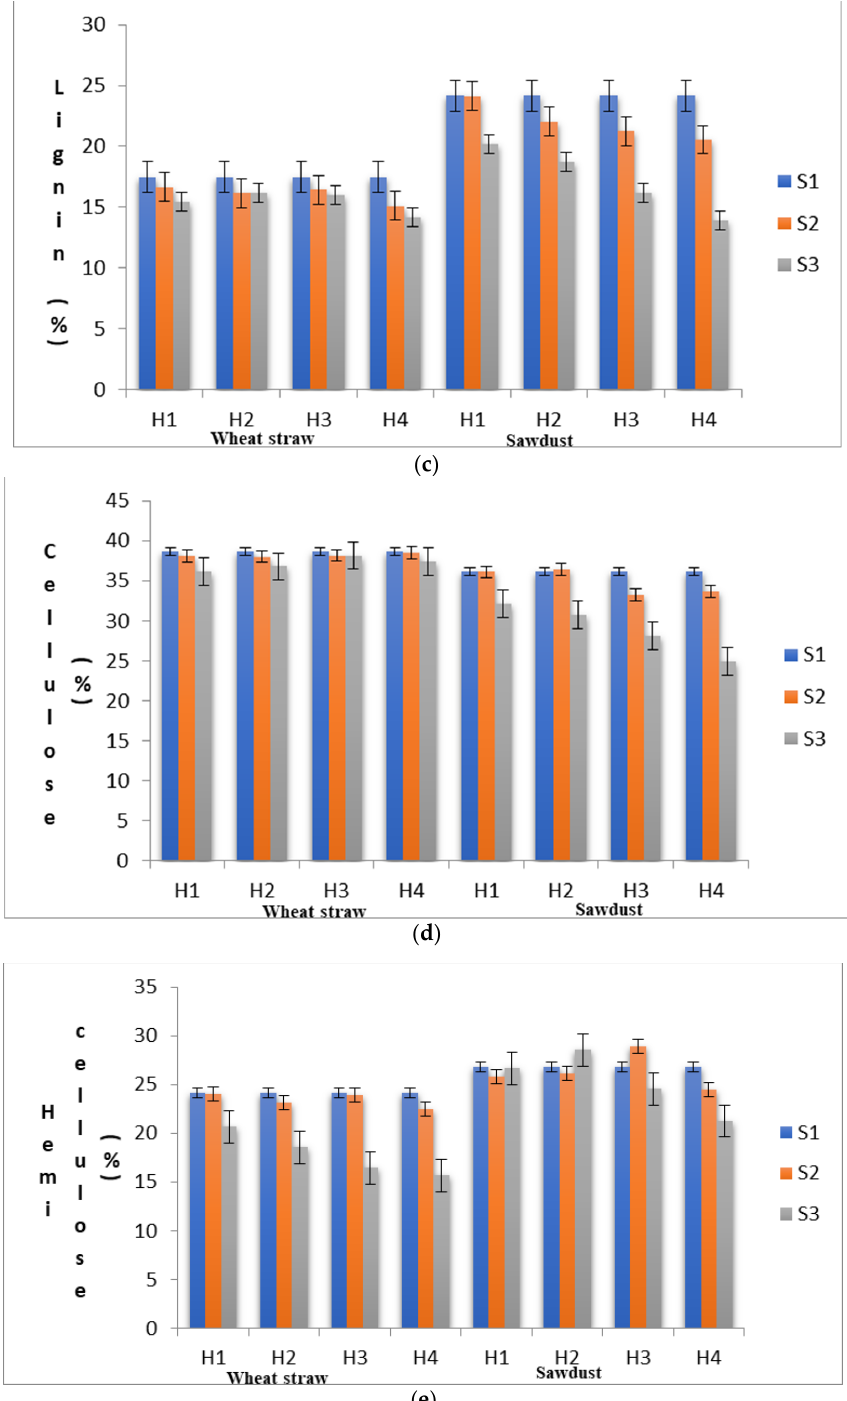
Figure 1. ( a ) Substrates’ moisture content in various experimental stages as influenced by pre heat treatment and subsequent SSF. ( b ) pH levels of the substrates in various experimental stages as influenced by pre heat treatment and subsequent SSF. ( c ) Lignin content of the substrates in various experimental stages as influenced by pre heat treatment and subsequent SSF. ( d ) Cellulose content of the substrates in various experimental stages as influenced by pre heat treatment and subsequent SSF. ( e ) Hemi-cellulose content of the substrates in various experimental stages as influenced by pre heat treatment and subsequent SSF. (S 1 , before heat treatment, S 2 , in the mycelium inoculation stage, S, in the primordial formation stage). When an initial substrate was exposed to heat treatment, it will undergo several physical and chemical changes, and the heat treatment per se may in turn affect mycelial growth, crop productivity and flushing patterns [30]. In the present study, the moisture content in WS was reduced from 67.70% (S 1 ) to 62.50% (S 3 ) and in SD, it was reduced from 66.87% (S 1 ) to 60.56% (S 3 ). In SD, the pH was reduced from 6.29 to 6.11 in the S 2 stage and further to 3.86 in the S 3 stage under H 4 . This rapid reduction in the pH of the substrate during the mycelial colonization phase might be a prerequisite for primordial initiation. This rapid reduction in the pH level might be due to the formation of organic acids during the substrate degradation process by L. edodes [31,32]. A similar trend of rapid reduction in the substrate’s pH was also reported by Peksen et al. [33] in Ganodermalucidum and by Atila et al. [34] in Hericium erinaceus . The percentage of change in the pH levels in WS from the S 1 to the S 2 stage was found to be highest under H 4 (−2.36%), whereas the pH percent- age change from S 2 to S 3 was found to be in the range from −12.34% (H 1 ) to −45.63 (H 4 ) (Table 2). Interestingly, the percentage change in the substrate pH levels increased signif- icantly with the increase in heat treatment duration. The change in the pH levels directly influenced fungal growth by affecting enzyme degradation and the solubility of com- pounds and increasing their availability to the fungus. Table 2. Percentage of change in the lignocellulosic content of the wheat straw substrate due to heat treatment and solid-state fermentation. Sampling Stage Heat Treat- ments